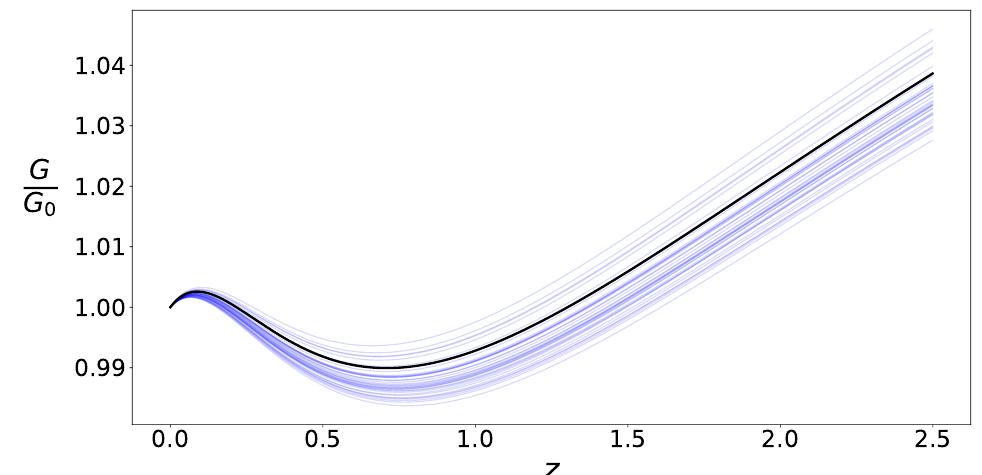
Figure 1. Evolution of G vs redshift. The line is drawn using the best fit values for b 1 , b 2 , and b 3 while the blue lines are some sample error lines with one χ 2 difference ( ∆ χ 2 = 1) from the black